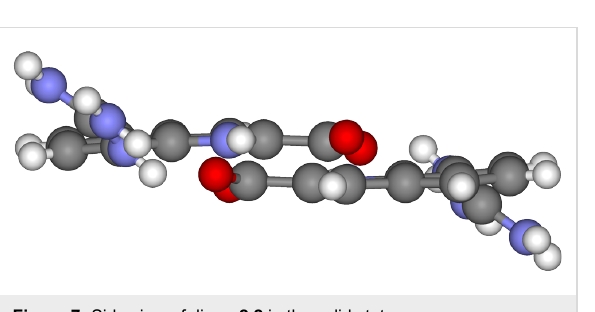
optimal interaction of the carboxylate with the NHs of the guan- idinium group the second molecule has to be a little bit out of plane of the first, which results in longer hydrogen bond distances for the guanidinium N ... O and the indole N ... O (Figure 7) and less favorable H-bond angles within the dimer (164.78° for the outer and 148.97° for the inner guanidinium NH-bonds and 141.37° for the indole NH-bond). Within the crystal lattice the molecules of 2 are arranged in parallel planes held together most likely by aromatic stacking interactions: The centroid-centroid distance of two indoles is 3.636 Å. Furthermore, the “backside” of the out of plane twisted guanidinium cation also interacts with the carboxylate group one plane below (Figure 8). The corresponding hydrogen bond distances are 2.790 Å and 2.922 Å, respectively, and are dimer.